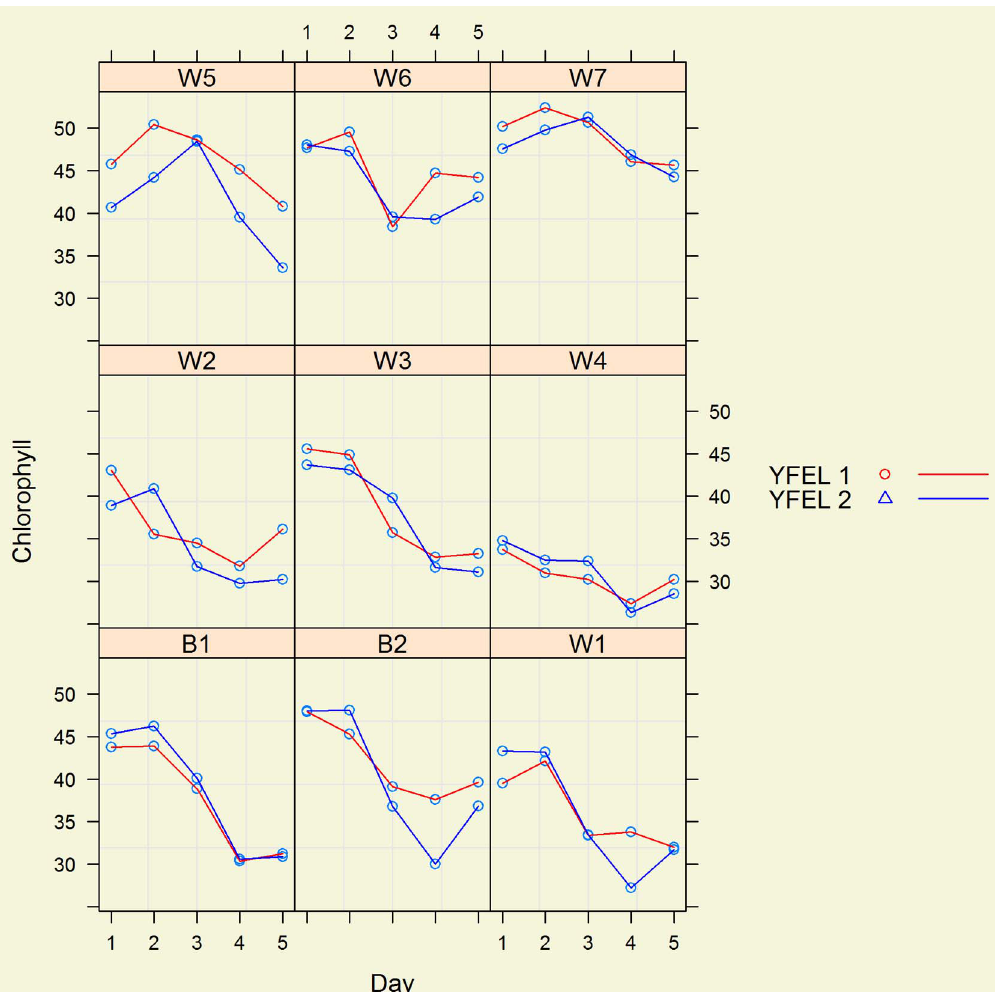
Figure 2. Declining pattern of SPAD units (chlorophyll) for the first young fully expanded leaf (YEFL1) and the second young fully expanded leaf (YEFL2) from the first through to the fifth (1, 2, 3, 4, 5) day of SPAD measurements for 7 wheat (W1–W7) and 2 barley (B1 and B2) genotypes in experiment 1.